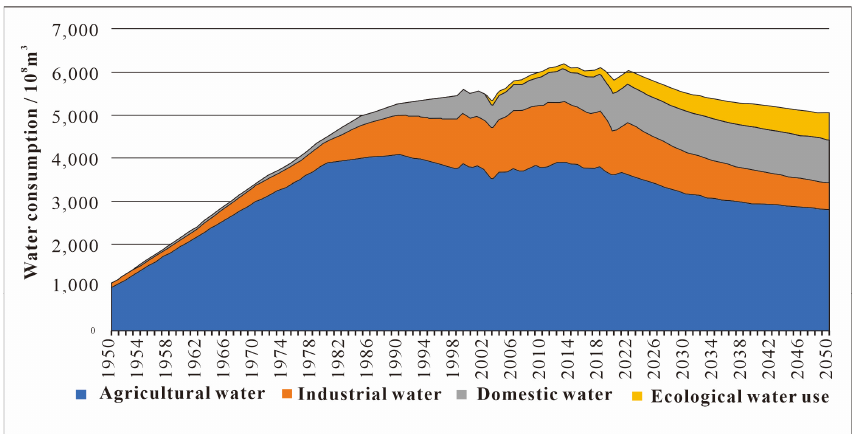
Figure 4. Consumption/demand of water resources and sector structure in China from 1950 to 2050.